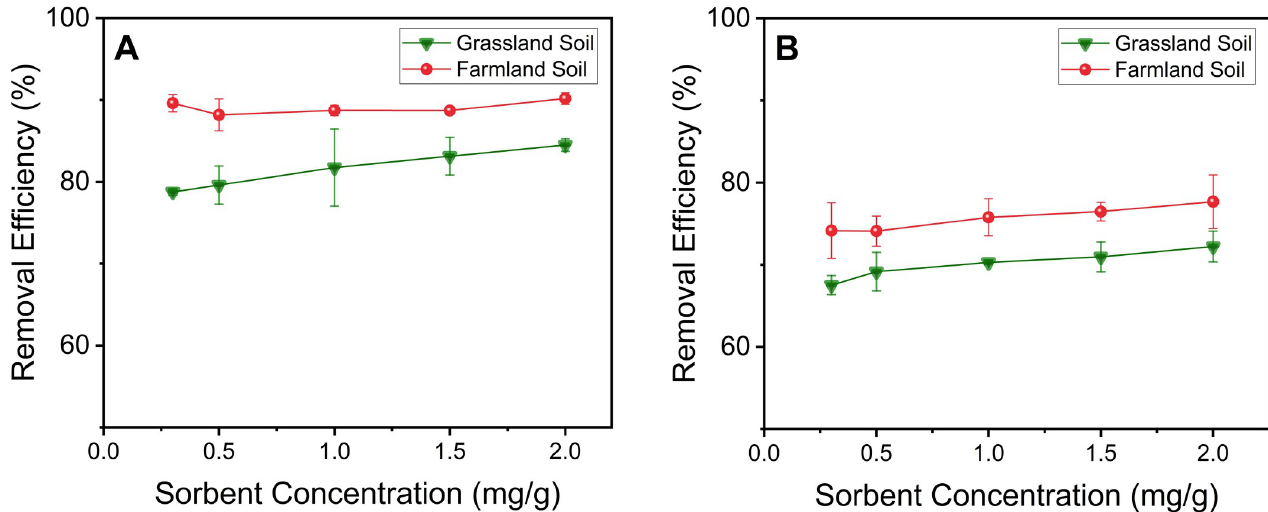
Fig 2. Removal efficiency of Cd 2+ or Pb 2+ by Ligand DNPs at different sorbent concentrations (mg sorbent/g soil), in a 7-day batch study at pH 7, from two soil types contaminated with (A) Pb 2+ or (B) Cd 2+ .